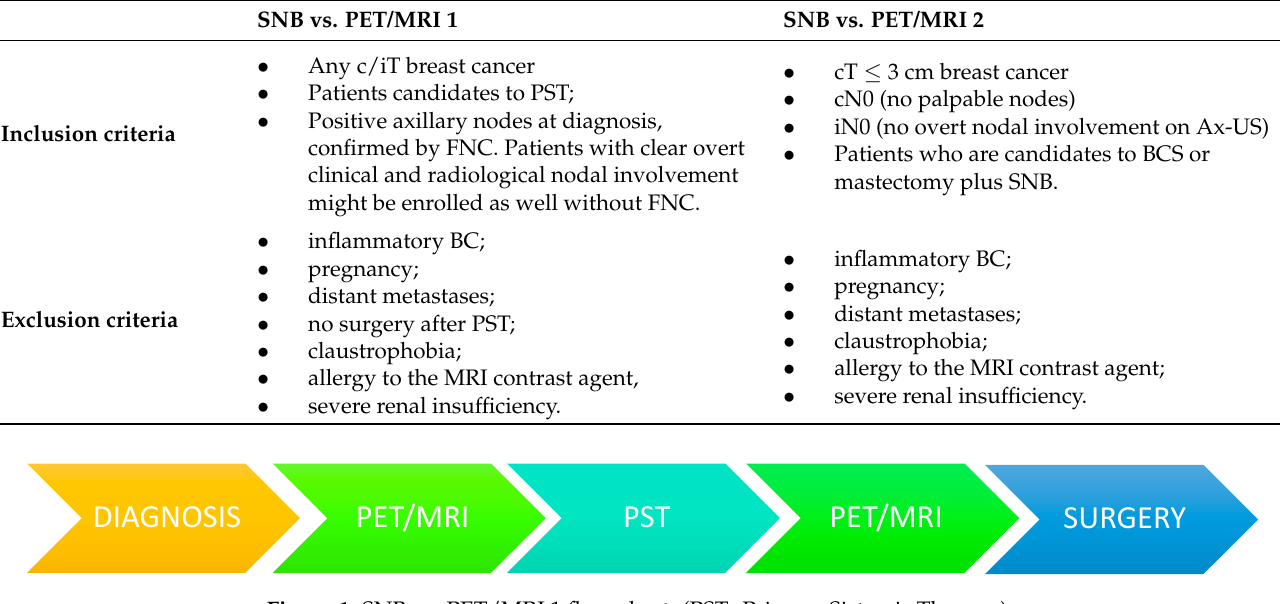
Figure 1. SNB vs. PET/MRI 1 flow-chart. (PST=Primary Sistemic Therapy).